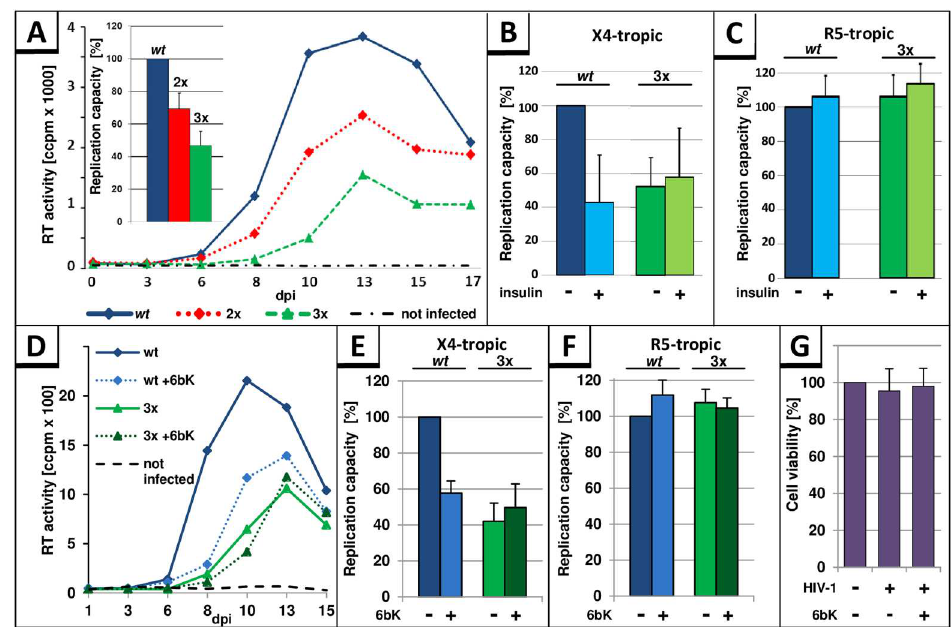
Fig 11. The stability of p6 correlatesinverselywith the replication capacityof HIV-1 and sensitivity to insulin in X4-tropic replication. (A ) A representative replicationprofileof HIV-1 NL4-3 variantsis shownfor PHA-IL2-stimulatedPBMCs, infected with wt , 2xPTAPPA (2x), 3xPTAPPA (3x) (30 pg p24, MOI 10 − 4 ) or mock infected, andreplicationwas assessedby quantification of the virus-associatedreversetranscriptase (RT) activity containedin cell culture supernatant collectedon the indicated days post infection (dpi). The replication capacityof X4-tropic HIV-1 NL4-3 wt , 2xPTAPPA or 3xPTAPPA followinginfectionof PHA-IL2-stimulated PBMCs from 6 differentdonors was assessed by calculating the area underthe curve (AUC) from each individualreplicationprofile. The replicationcapacityof HIV-1 NL4-3 wt in eachexperimentwas set to 100%. Error bars, ± SD (Inset). ( B )Replicationcapacityof X4-tropic HIV-1 NL4-3 wt or 3xPTAPPA with or without permanent treatment with 50 μ g/mlinsulinfollowinginfectionof PHA-IL2-stimulatedPBMCs from 3 different donors.The replicationcapacityof HIV-1 NL4-3 wt from each experimentwas set to 100%. Error bars, ± SD. ( C ) Replication capacityof R5-tropicHIV-1 NL4-3 wt or 3xPTAPPA with or withoutpermanent treatment with 50 μ g/ ml insulinfollowing infection of PHA-IL2-stimulatedPBMCs from 3 different donors.The replication capacityof HIV-1 NL4-3 wt from eachexperimentwas set to 100%. Error bars, ± SD. (D) PHA-IL2-stimulatedPBMCs were infectedwith HIV-1 NL4-3 wt or 3xPTAPPA and permanently treated with 10 μ M 6bK, or wereleft untreated. Replication capacitiesweredetermined as describedin (B) for PHA/IL-2-stimulated PBMCs from 3